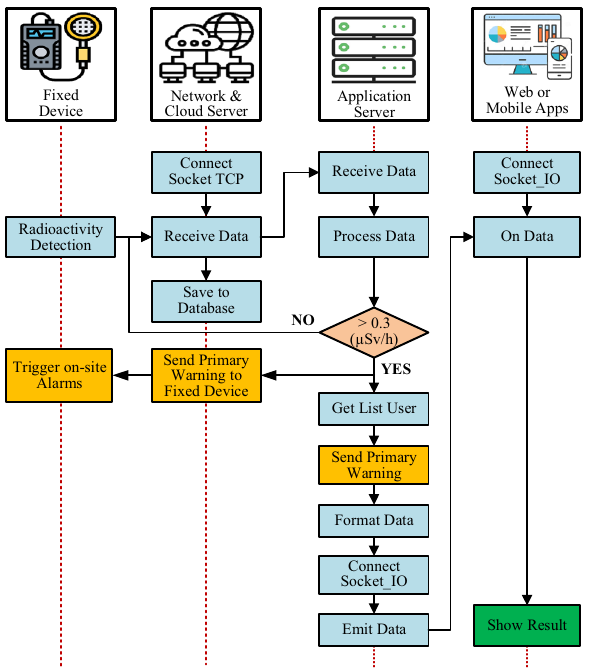
Figure 9. Flowchart of radiation detection and primary warning activation on the fixed device.